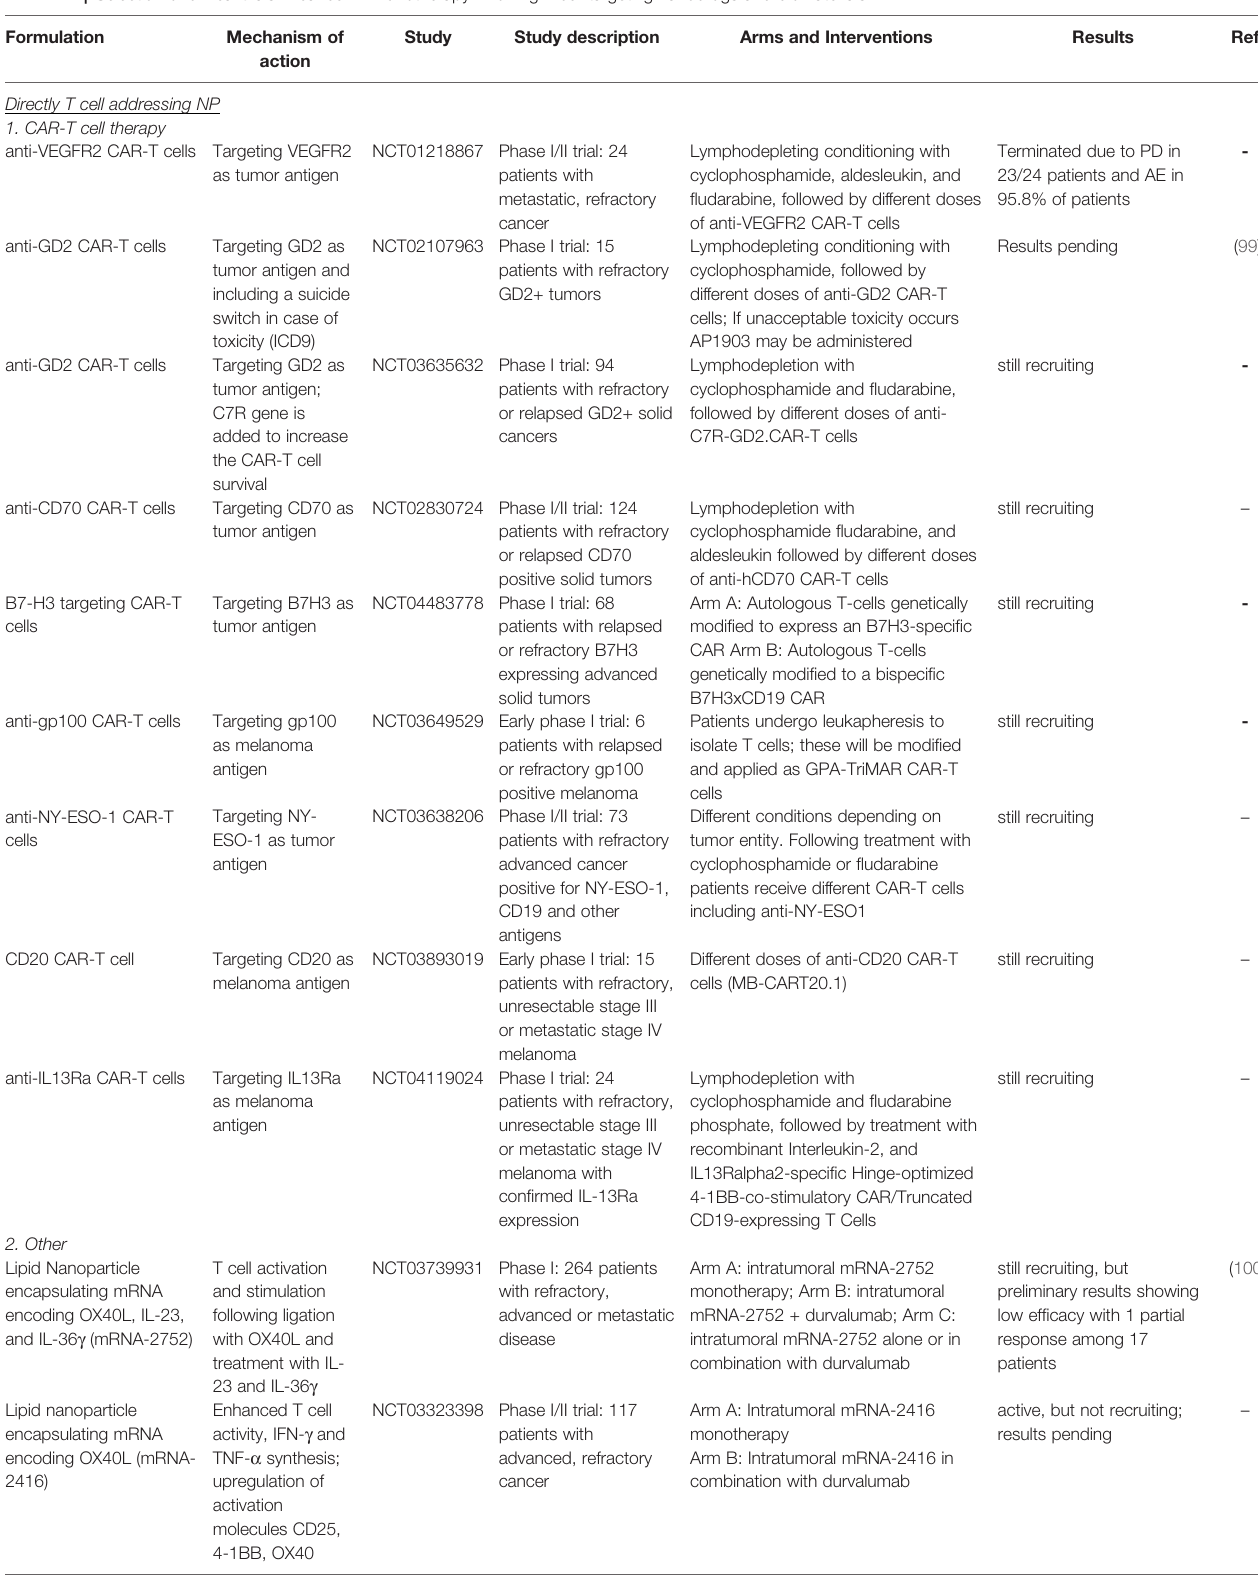
TABLE 1 | Selection of clinical trials in cancer immunotherapy involving T cell targeting nanodrugs and